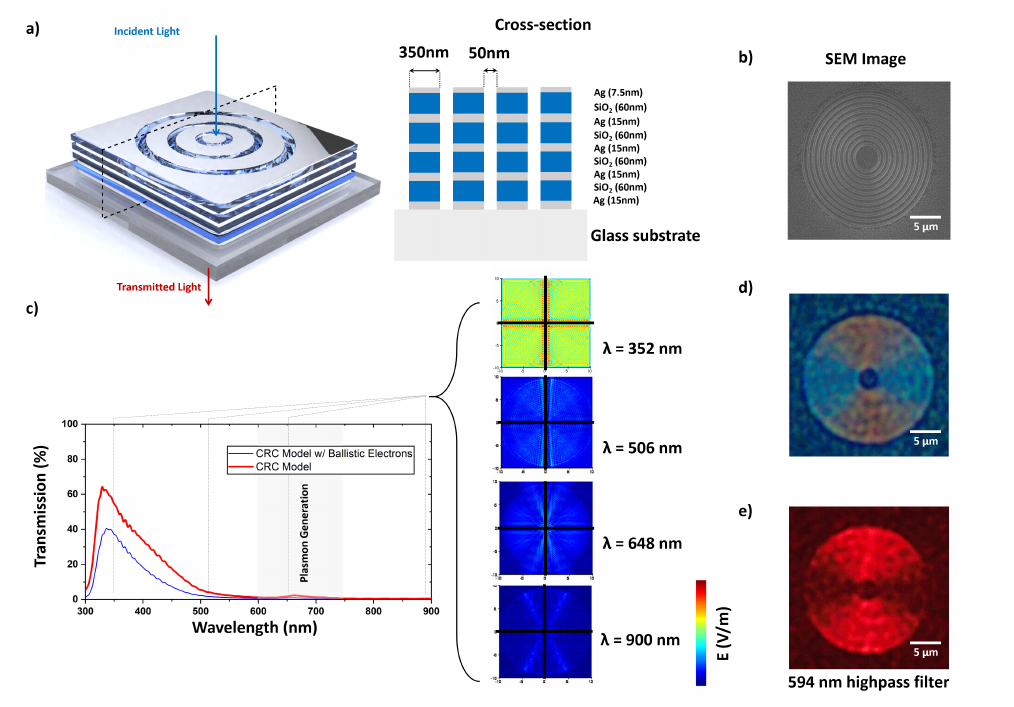
Figure 5: (a) 3D model of the concentric array of circular rings hyperbolic metasurface. (b) SEM image of a concentric array of circular rings with 50 nm width separated by 400 nm . (c) Simulated normalized transmission spectrum of the metasurface and field maps. (d) far-field optical image of the light transmitted through the metasurface indicated in (b) after a light polarized in the horizontal axis. (e) is the (d) image with 594nm high pass filter has been applied (red